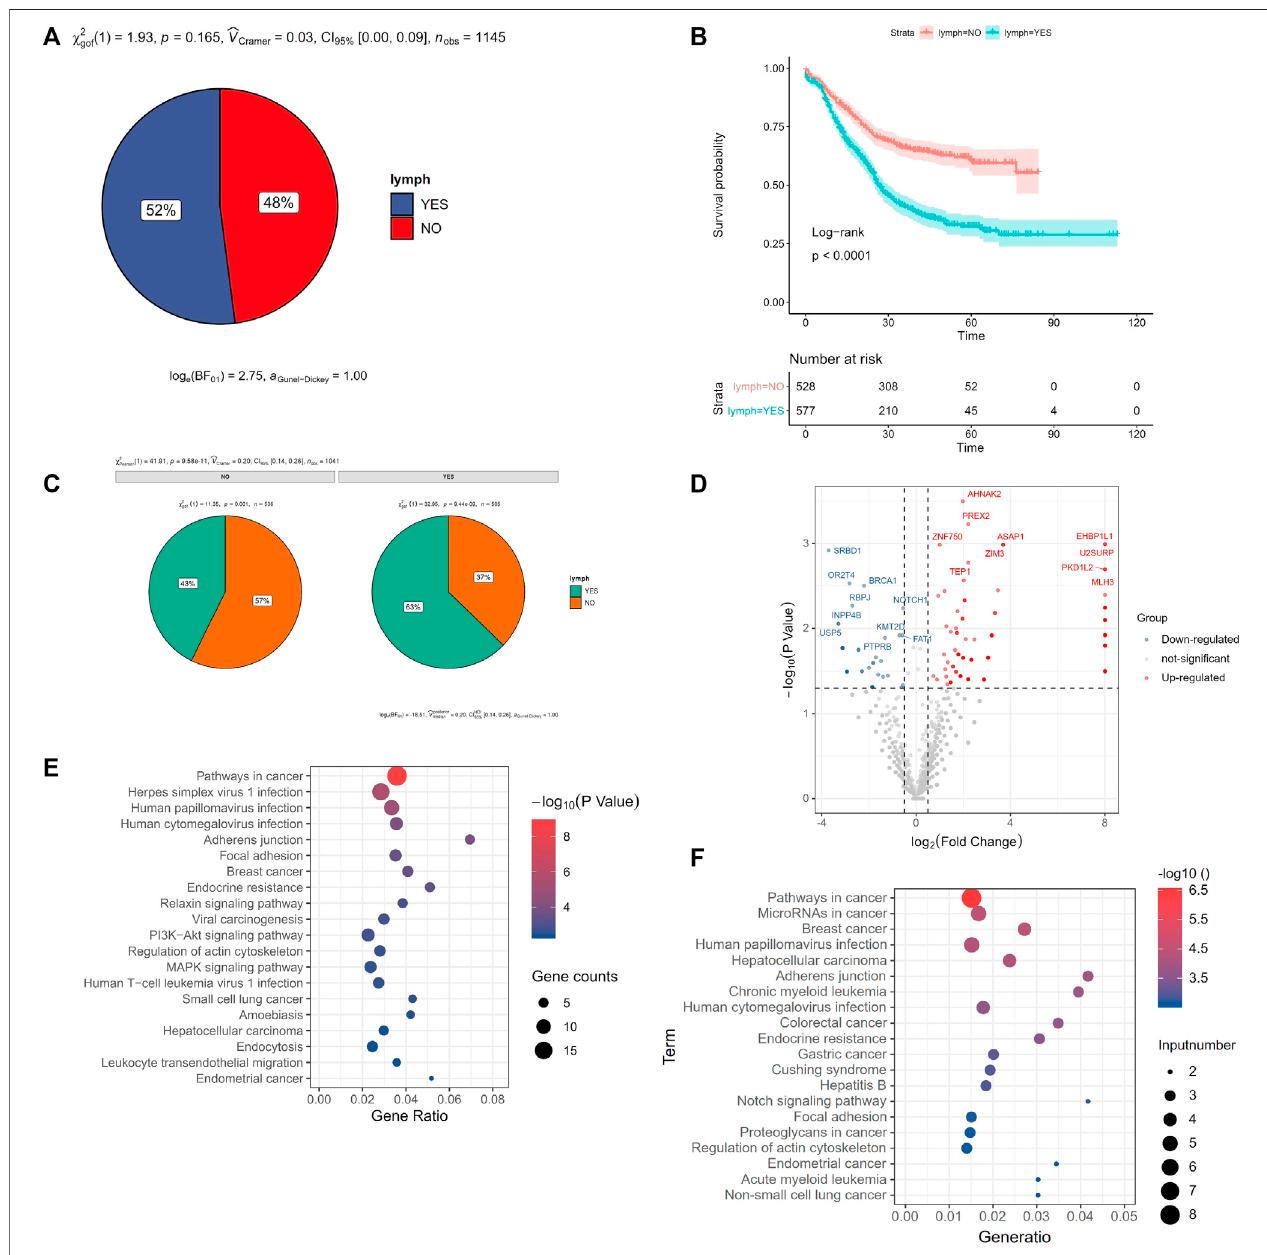
FIGURE 6 | Gene mutation with lymph node metastasis. (A) the frequency of lymph node metastasis in ESCC, (B) Survival analysis of lymph node metastasis in ESCC, (C) smoking related with lymph node metastasis in ESCC, (D) volcano plot of the correlation gene mutation with lymph node metastasis, x -axis was the log 2 (the ratio of mutated rate of lymph node metastasis group and the mutated rate of without lymph node metastasis group), and y -axis was P (the correlation gene mutation with lymph node metastasis), (E) KEGG enrichment pathway ofthe higher mutation gene of lymph node metastasis compared with no lymph node metastasis, (F) KEGG enrichment pathway of the lower mutation gene of lymph node metastasis compared with no lymph node metastasis.